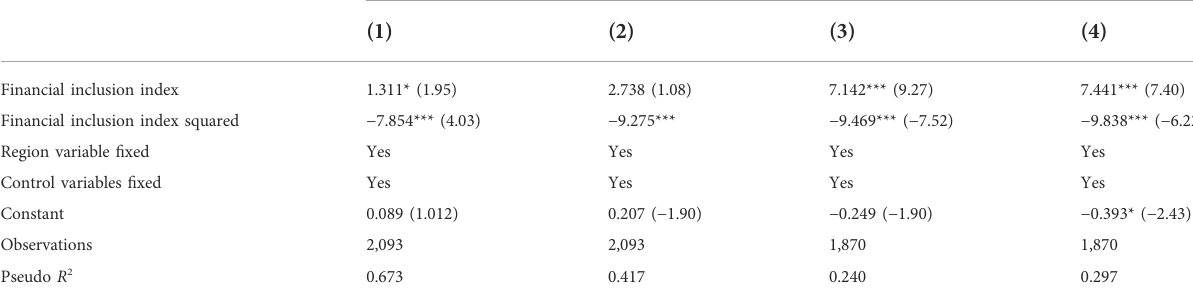
TABLE 5 Robustness test results.